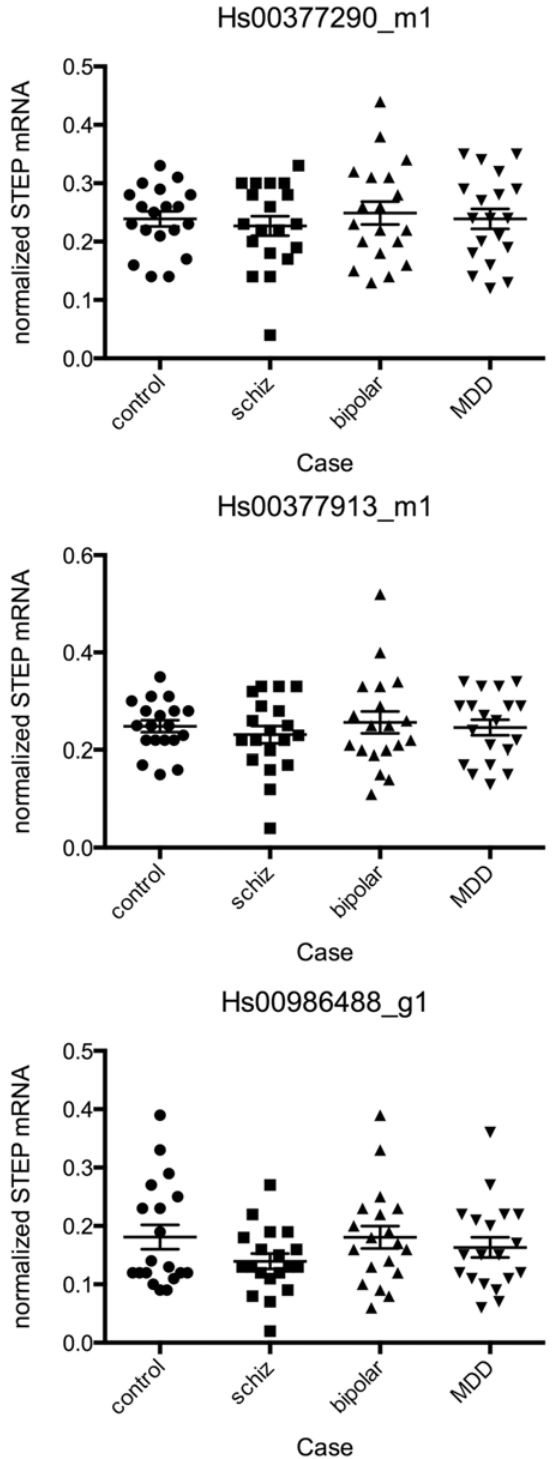
Fig 1. STEP61 mRNA levels were measured by RT-PCR in PFC from subjects with schizophrenia, bipolar disorder, MDD, or age-matched controls using probe sets specific for different sequences within the STEP transcript (titles are Taqman assay numbers). No statistically significant changes were observed using any of the probe sets for